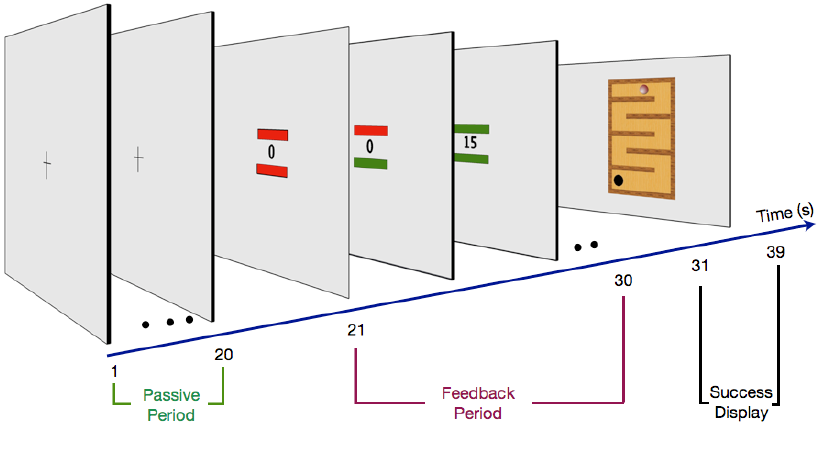
Figure 2. The neurofeedback design. Neurofeedback training: during the passive period (20 s) volunteers fixated the central cross. This period was used to assess an actual baseline value of alpha or gamma current density power in the ROIs. In the feedback period (second 21–30) participants tried to increase the current density power in the ROIs (value at fixation) and at the same time avoid EOG (bar above value) and EMG (electromyography) (bar below value) artifacts by keeping the bars green . As an artifact occurred (at least one of the bars red ) the presented value was set to zero. The success of the intentionally increased artifact free gamma or alpha values was presented after the feedback period (success display).